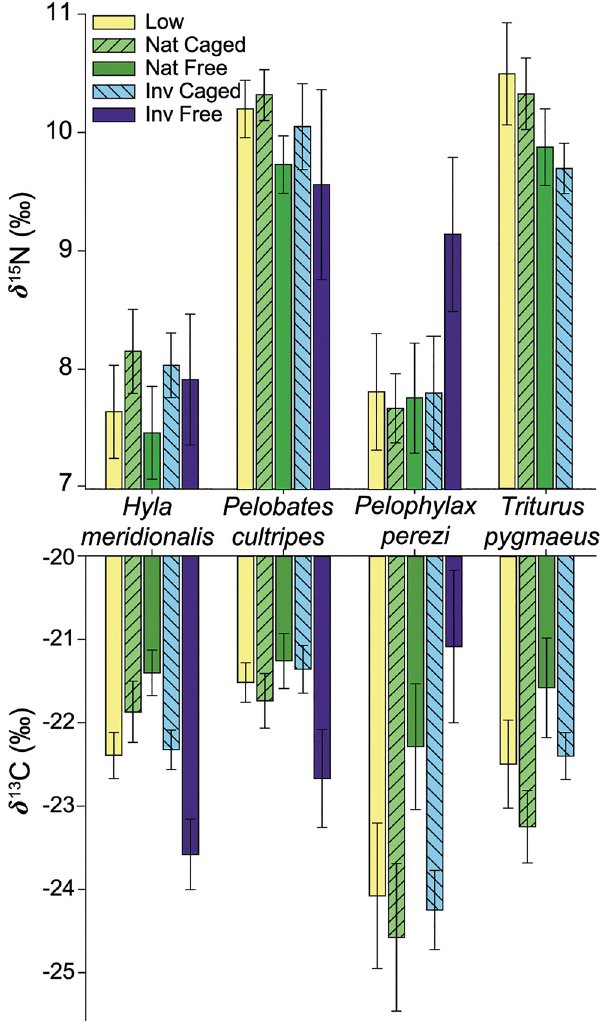
Fig 3. Stable isotopic values for each amphibian species in the presence / absence of predators. δ 15 N and δ 13 C values (mean ‰ ± SE) of H . meridionalis , P . cultripes , P . perezi , and T . pygmaeus muscle in the presence of native dytiscid larvae (free or caged, Nat Free or Nat Caged ), or in the presence of invasive red swamp crayfish (free or caged, Inv Free ,or Inv Caged), compared to absence of predators ( Low ). Predator effects: type of predator and lack of non-consumptive effects. Predators influ- enced the isotopic signatures of carbon and nitrogen (Fig 3 and S5 Table). Native predators only exerted significant changes in isotopic values in the newts. We found higher δ 13 C value in T . pygmaeus when native dytiscid were free in the tanks compared to when they were caged = 8.95; P = 0.006) although these changes were not significant in the absence ( NatC - NatF : F 1,60 = 2.5; P = 0.12). Free crayfish, however, caused the biggest differ- of predators ( Low - NatF : F 1,60 ences in isotopic values. We found significantly lower δ 13 C in the presence of free crayfish com- = 4.21; P = 0.045) and pared to the absence of predators for H . meridionalis ( Low - InvF : F 1,59 = 5.24; P = 0.025), or when crayfish were caged ( InvC -InvF: for P . cultripes ( Low - InvF : F 1,81 F = 4.97; P = 0.044 and F = 6.77; P = 0.015 for Hyla and Pelobates respectively). On the 1,59 1,81 contrary, P . perezi showed higher δ 13 C in the presence of free crayfish, both compared to the